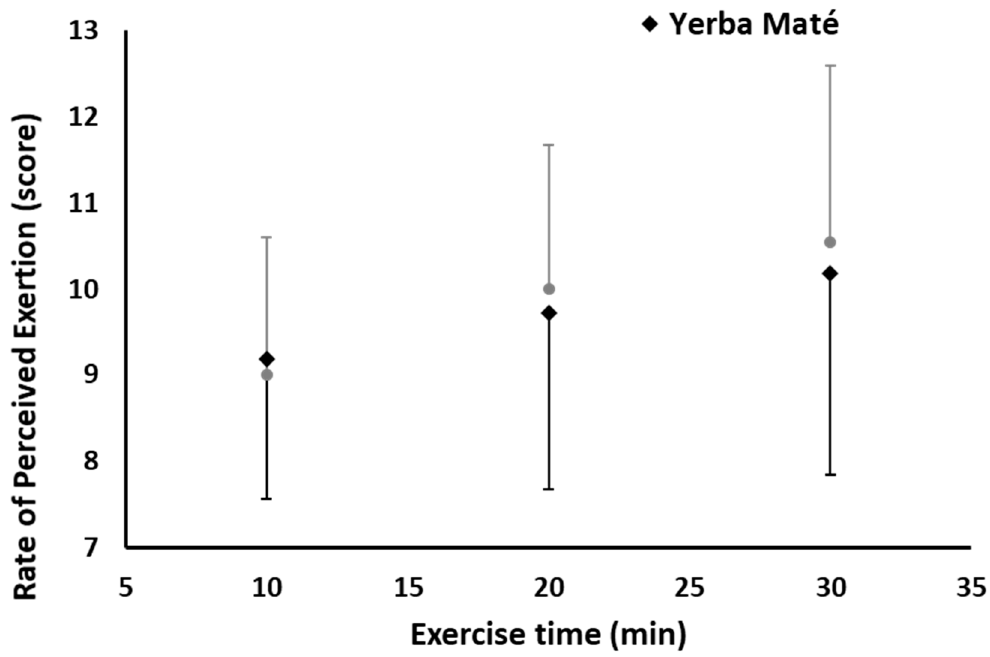
Figure 5. Rate of perceived exertion during exercise in Yerba Mate (YM) vs. placebo (PLC).